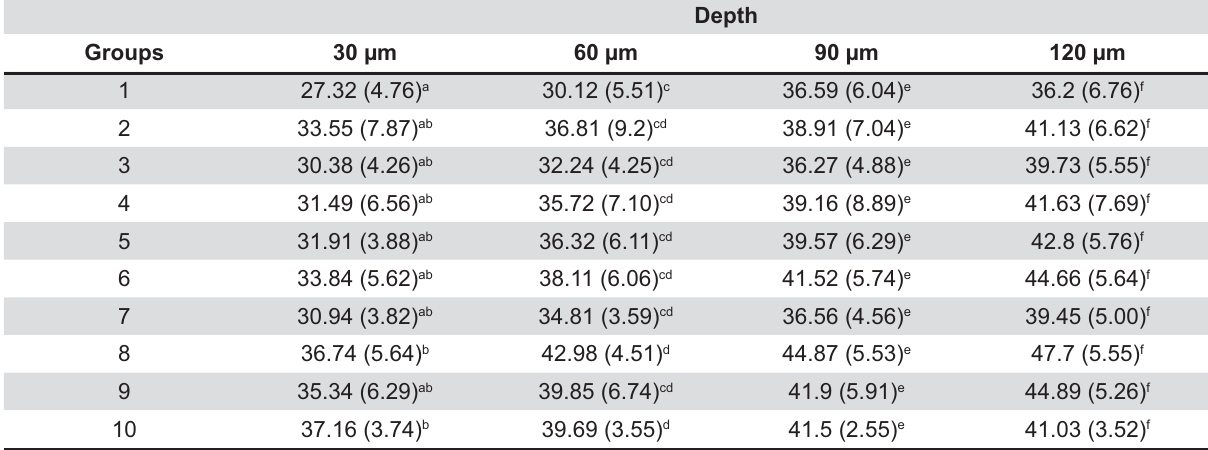
Table 2- Knoop microhardness numbers (± the standard deviations) found at different depths for all groups after the acid